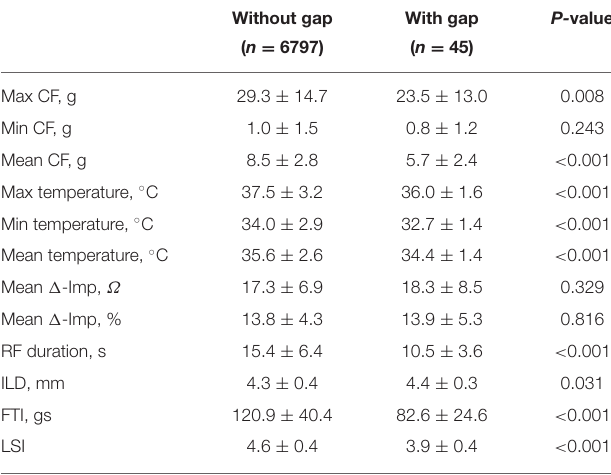
TABLE 3 | Comparison of ablation lesion characteristics with and without gaps. Without